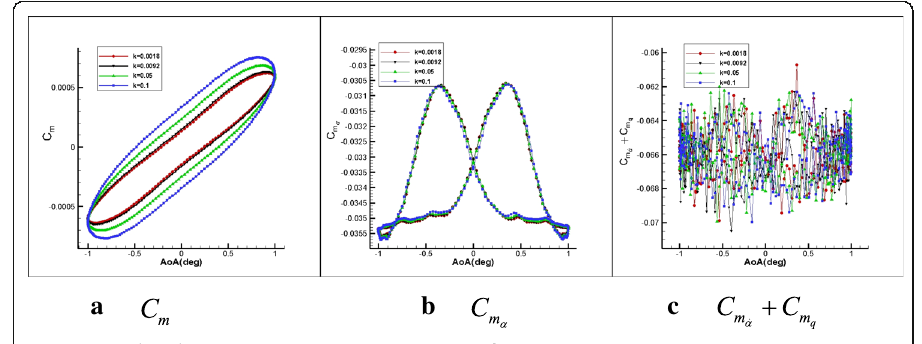
Fig. 3 C m and its derivatives at α 0 = 0 ∘ , X cg /L = 0.70. a C m . b C m